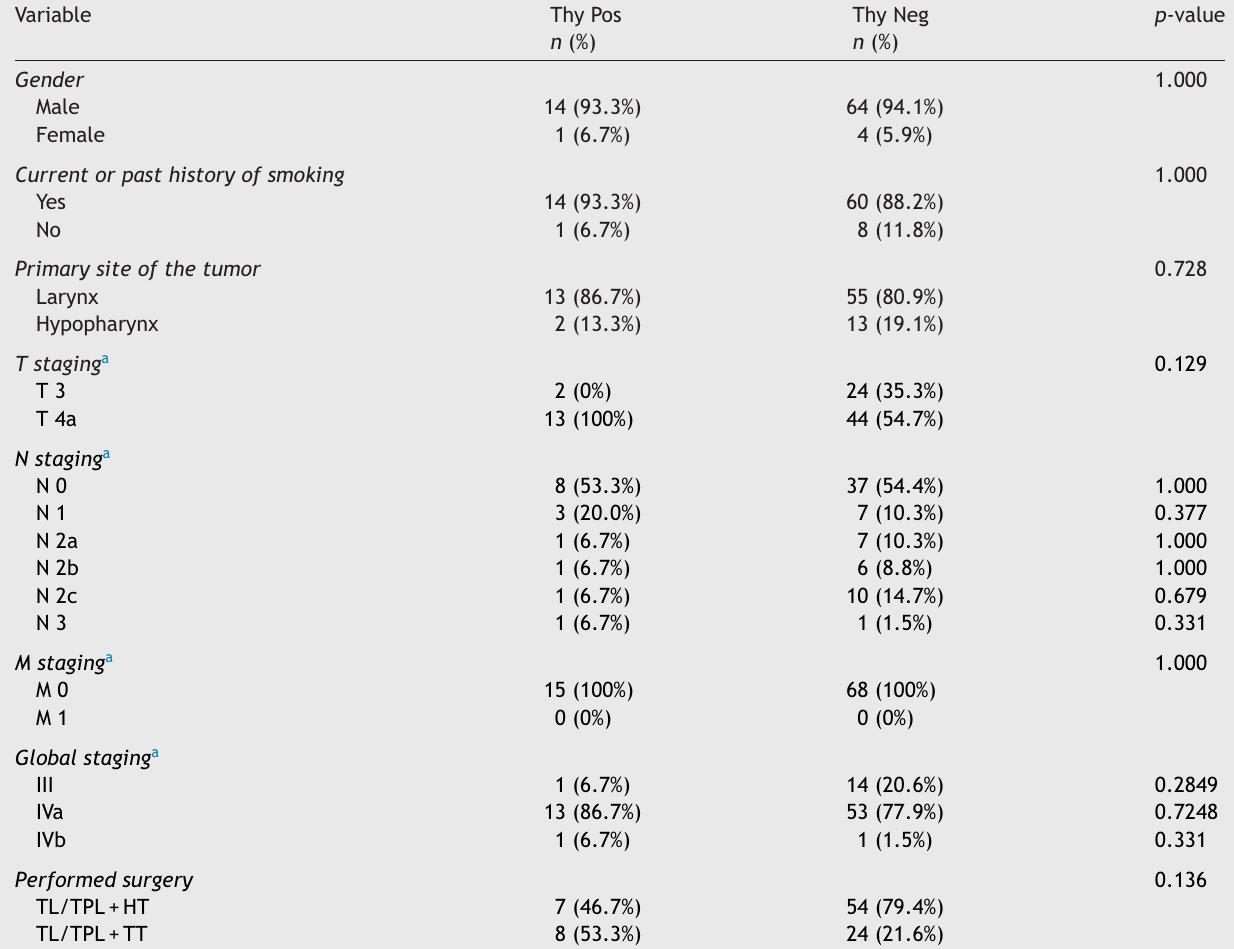
Comparison between groups of patients with laryngeal and/or hypopharyngeal SCC submitted to TL or TPL with HT or TT --- clinic-epidemiological